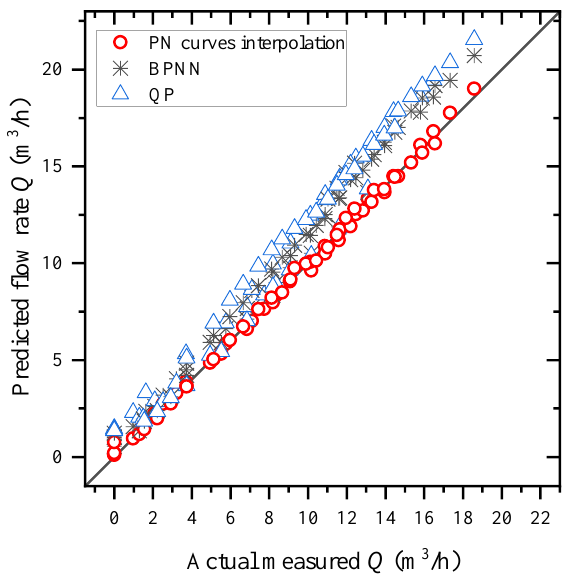
The horizontal and vertical axes of Figure 13 show the measured and predicted flow rates, respectively. The closer the points in the graph are to the line y = x, the closer the predicted flow is to the measured flow. Whether the flow rate is small or large, the point from the PN curves interpolation method is always the closest distance to the line y = x, which indicates that the PN curve interpolation method can better predict the flow rate (see Figure 13). Figure 12. Comparison of the predictive flow rates of the three methods. Figure 12. Comparison of the predictive flow rates of the three methods.